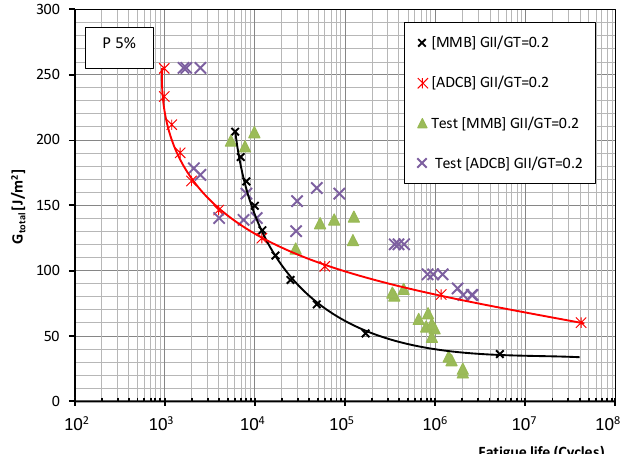
Figure 7. Fatigue behavior for a mode mixity ratio ( G II / G C ) of 0.2, a 5% failure probability, and the MMB and ADCB test methods.